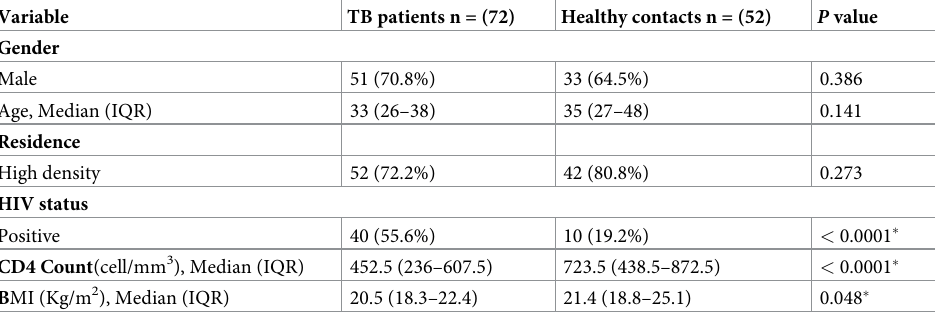
Table 1. Demographic and clinical characteristics of TB patients and their healthy contacts.